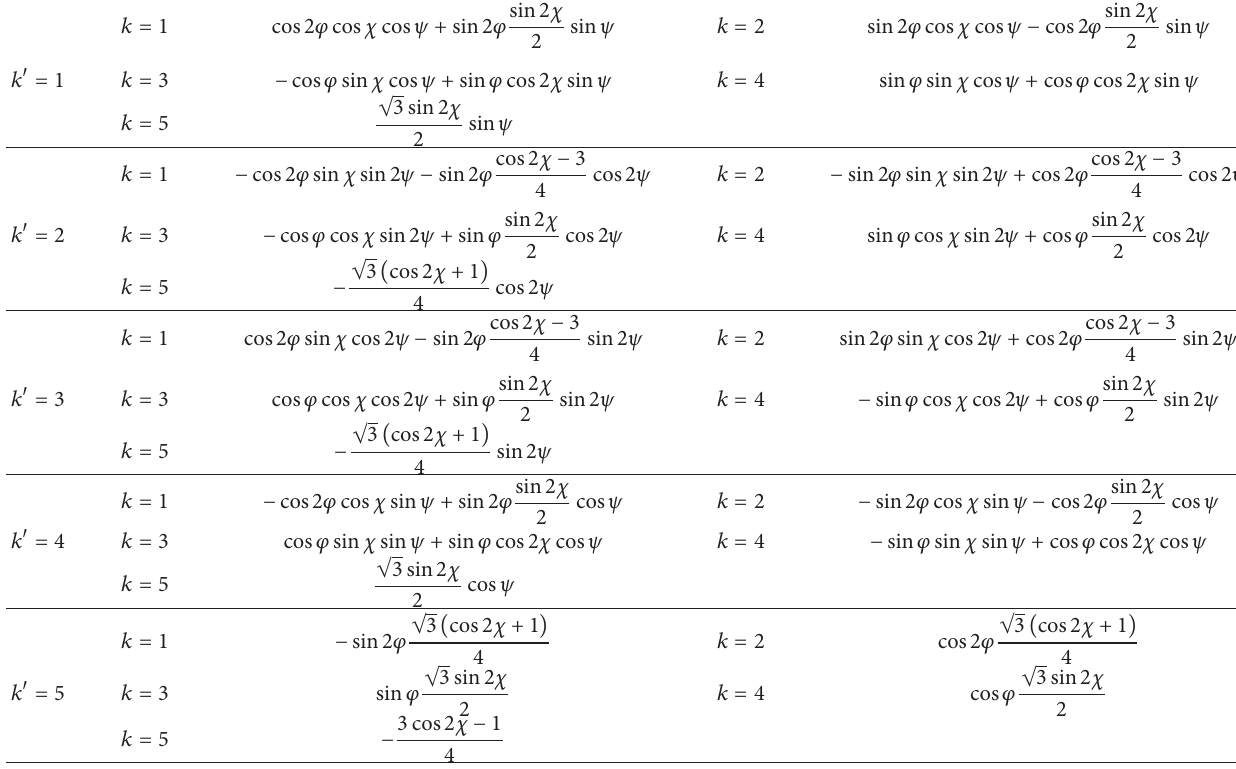
̃ R (𝜑,𝜒,𝜓) for Cardan angles ( 𝑘,𝑘 󸀠 ∈ {1, 2,3, 4, 5} ≡ 𝑚, 𝑚 󸀠 ∈ {1,3, 4,6, 8} Table 10: Expressions of −𝑘,𝑘 󸀠